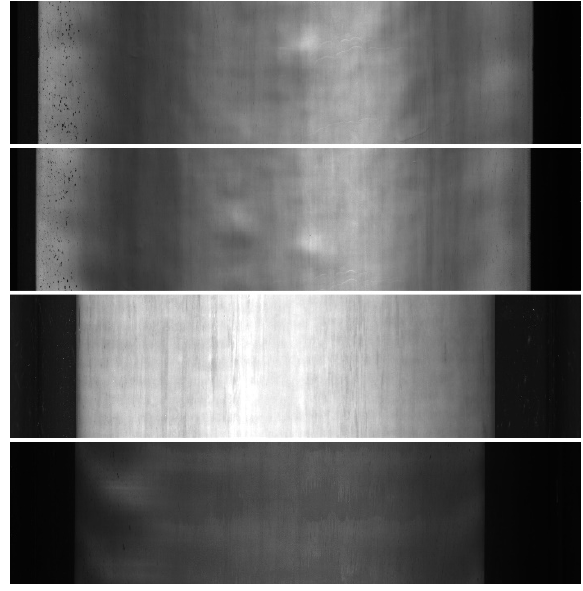
Figure 5. Samples of